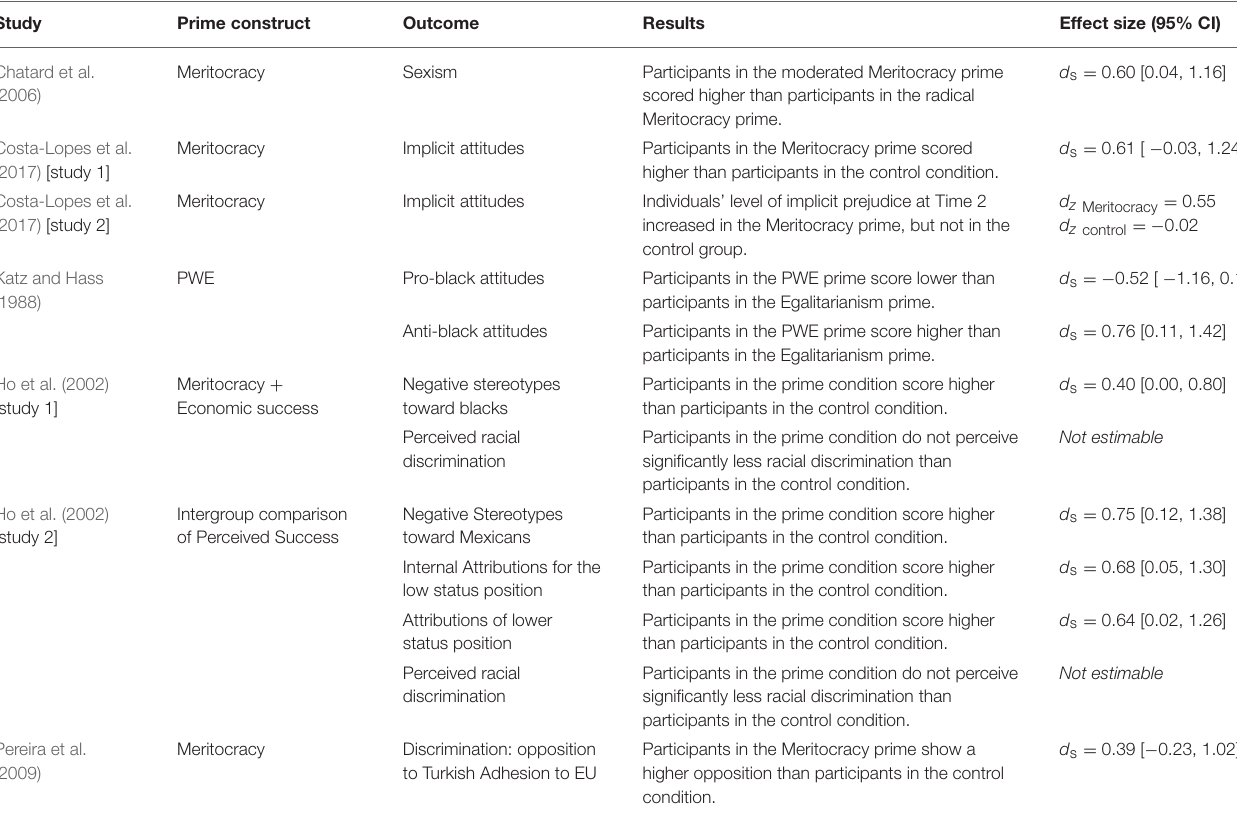
TABLE 2 | Summary of studies related with the Impact of Meritocracy on Attitudes, Beliefs and Perceptions involving Low status